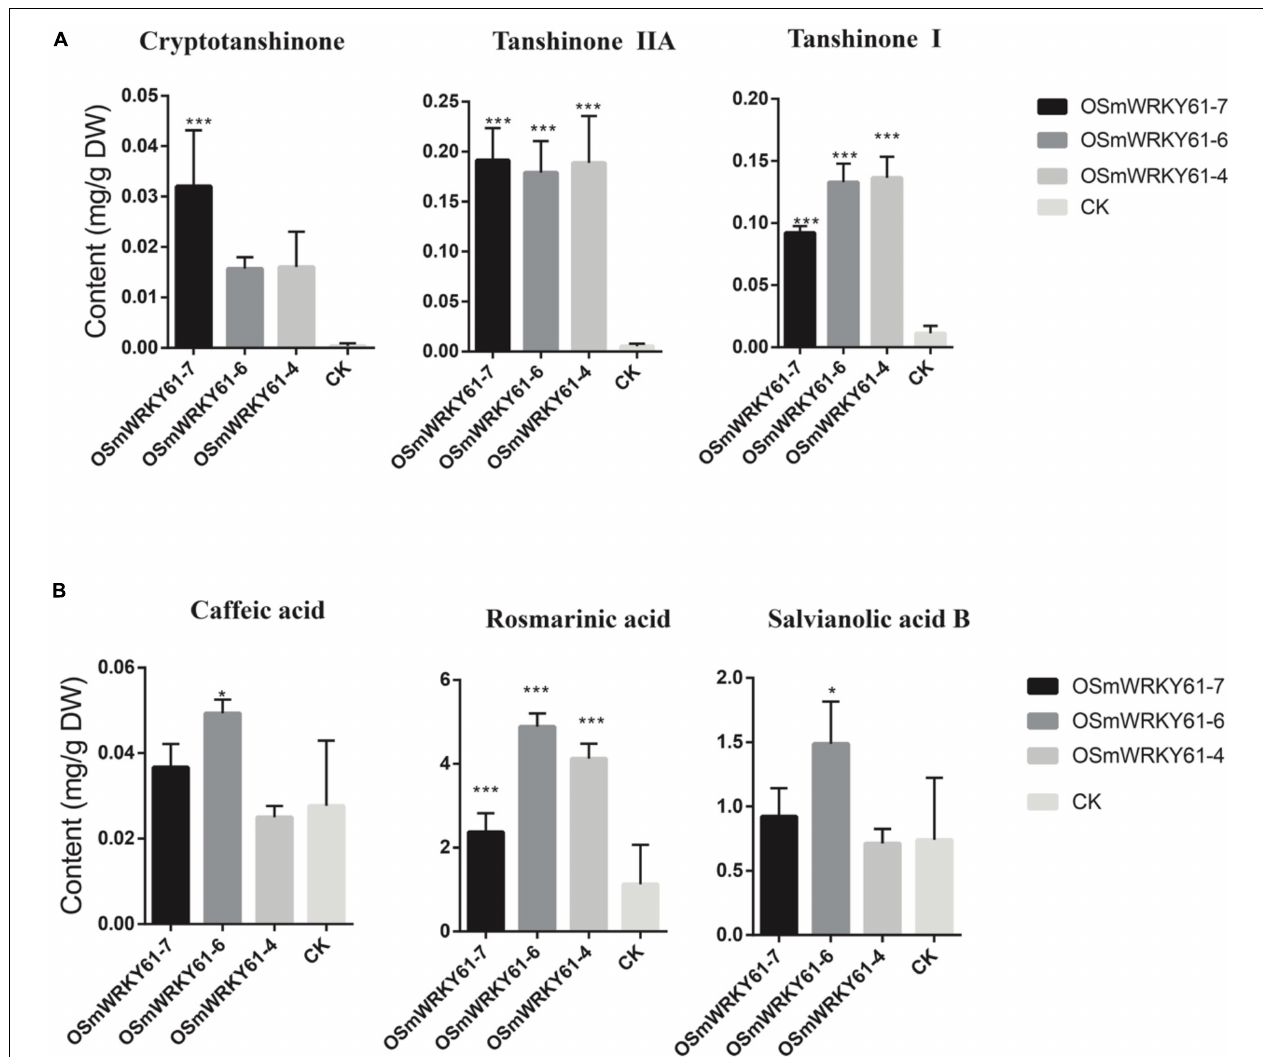
FIGURE 4 | Tanshinones and polyphenolic compounds contents of hairy roots in S. miltiorrhiza and S. castanea . (A) HPLC analyse of tanshinones (cryptotanshinone, tanshinone IIA, and tanshinone I) in S. miltiorrhiza hairy roots. (B) HPLC analyse of phenolic acids (caffeic acid, rosmarinic acid, and salvianolic acid). “CK” represent S. miltiorrhiza , “*” represents 0.01 < P < 0.05, “**” represents P < 0.01, “***” represents p < 0.001. All data are the means of three replicates; error bars represent the indicate